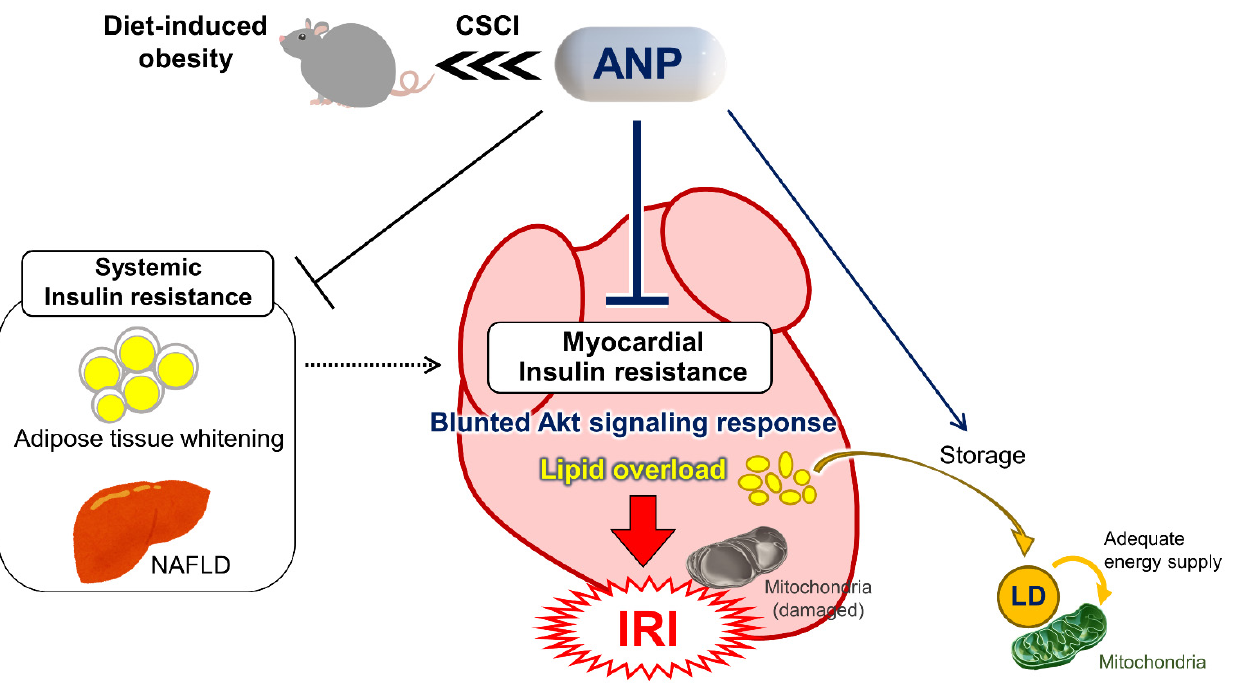
Figure 7. Exogenous ANP treatment in diet-induced obesity ameliorates not only systemic insulin resistance but also myocardial insulin resistance and protects against ischemia-reperfusion injury, which is associated with significant modifications of mitochondrial ultrastructure. CSCI, continuous subcutaneous infusion; IRI, ischemia-reperfusion injury; LD, lipid droplet; NAFLD, non-alcoholic fatty liver disease.